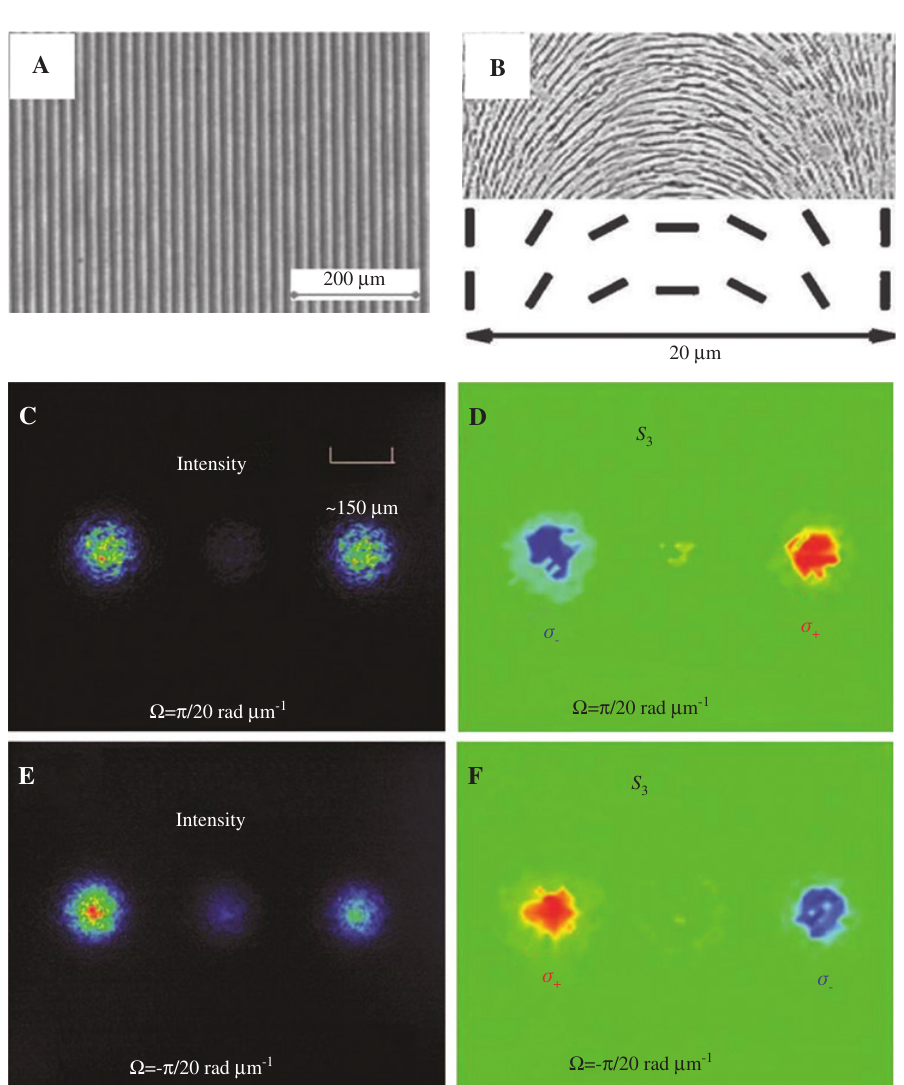
Figure 12: The far field giant photonic SHE observed after a linearly polarized beam passes through two structured metasurfaces. (A) and (B) are the polariscopic analysis result and SEM image picture of the applied metasurface. (C) and (D) show the intensity and S ter for the metasurface with a rotation rate of Ω = π /20 rad μ m -1 , respectively. (E) and (F) are the corresponding results for another sample with the exactly opposite rotational rate of Ω = - π /20 rad μ m -1 . The observation distance is 10 cm away from the metasurface. Adapted from Ref.